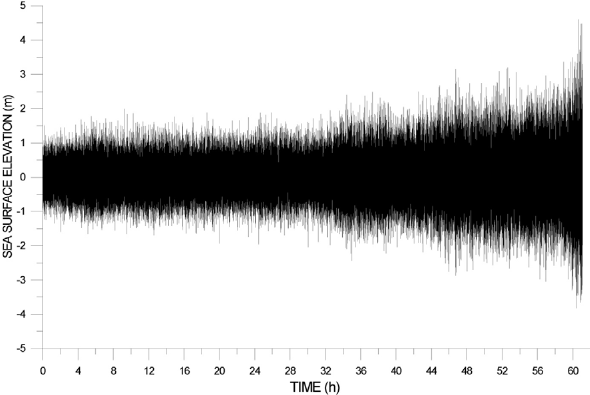
Figure 3. Variation of mean wave period with significant wave height